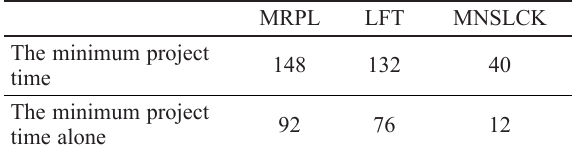
Table 3. Success project number of priority rules